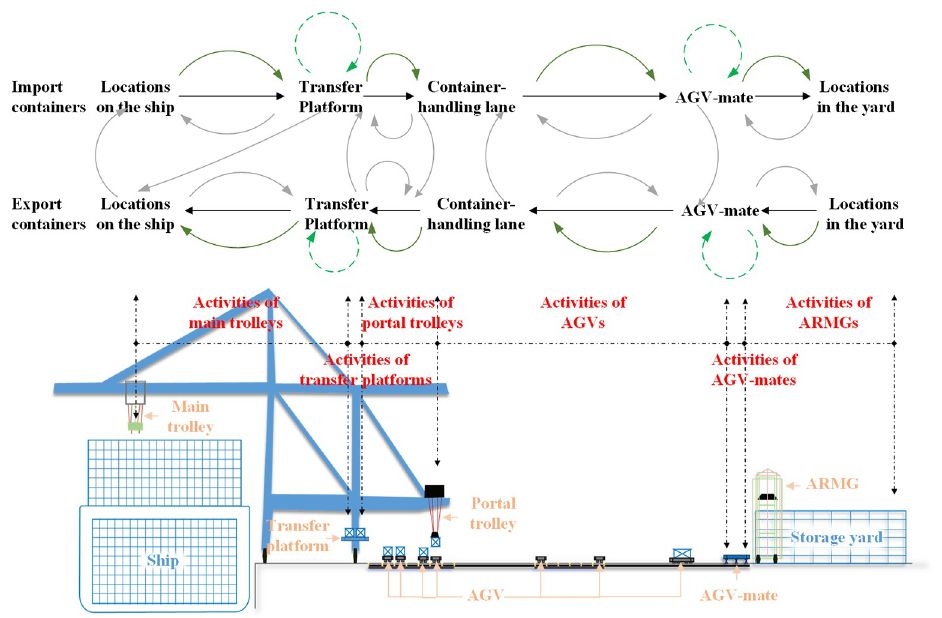
Fig 1. The operation process of equipment systems in